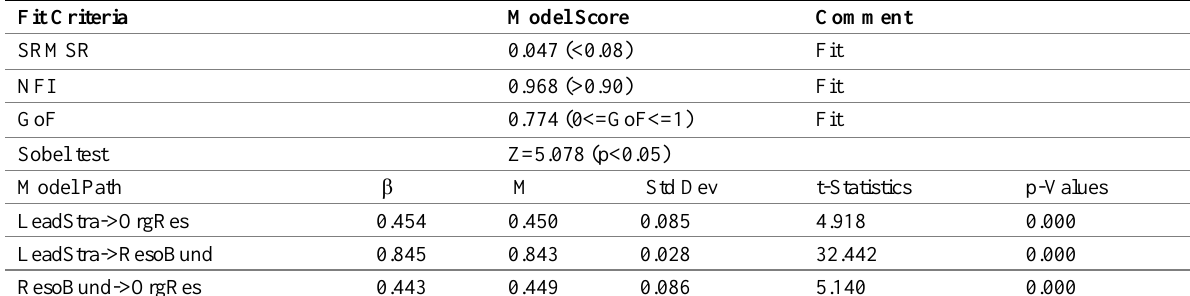
Table 5: Model Fit Criteria for Resource